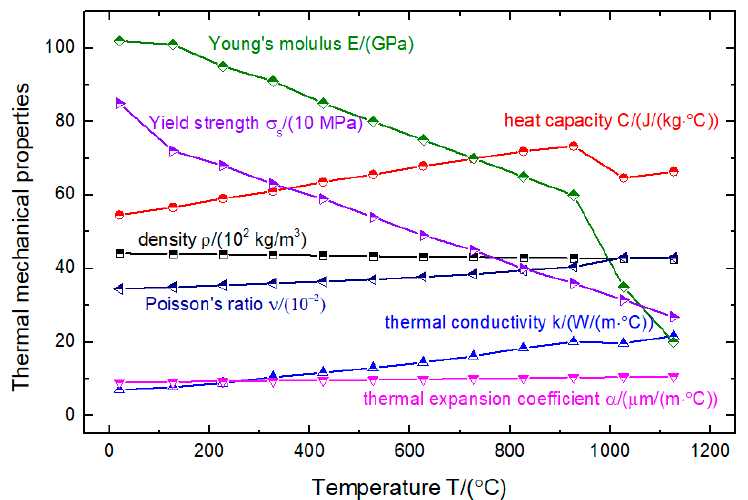
Figure 3. Temperature-dependent thermal mechanical properties of Ti-6Al-4V.